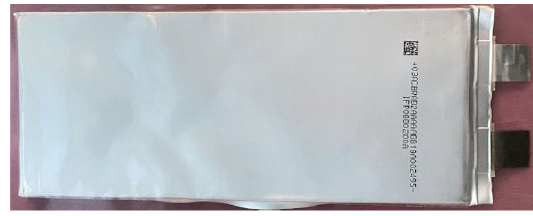
Figure 1. The picture of TLP80A5E6-50AH LIB. Table 1. LIB’s basic parameters.